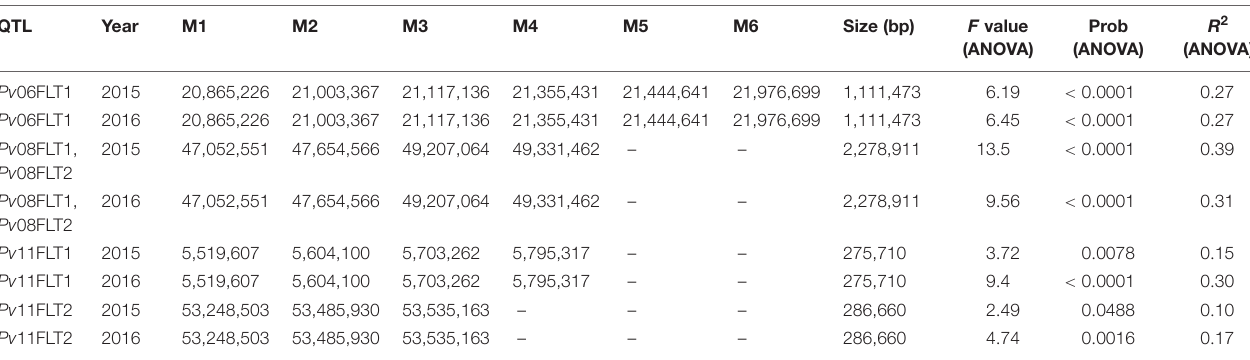
FIGURE 6 | Box plots showing the phenotypic distributions of total seed folate content for six QTL identified by GWAS with the FarmCPU model. The LSMEANS from the separate ANOVAs for the 2015 and 2016 experiments were plotted. Accessions that were heterozygous for the QTL marker were not included in the analysis. Each boxplot is labeled with the SNP genotype and the year (e.g., GG2015). The chromosomes and physical positions of the SNPs are indicated below each plot. TABLE 3 | Haplotype analysis of total seed folate content QTL identified by